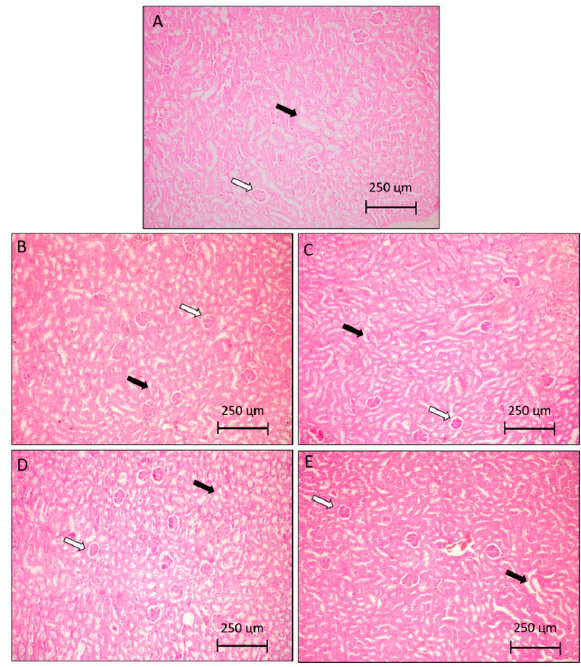
Figure 5. Photomicrographs representative of kidney histology (5 µm). Control group ( A ), are animals without tumor S180 treated with the vehicle (saline). The control group ( B ), are animals with tumor S180 treated with the vehicle (saline). Group ( C , D ) are animals with S180 tumor treated with PaLE 100 and 150 mg/kg/day, respectively. The positive control group ( E ), are animals with S180 tumor treated with 5-FU 25 mg/kg/day. The hollow arrows indicate Bowman’s space and arrows filled with preserved proximal twisted tubules. 100× magnification. Table 5. Effect of Pa LE (i.p.) on hematological parameters of peripheral blood in mice with and without S180 tumor.